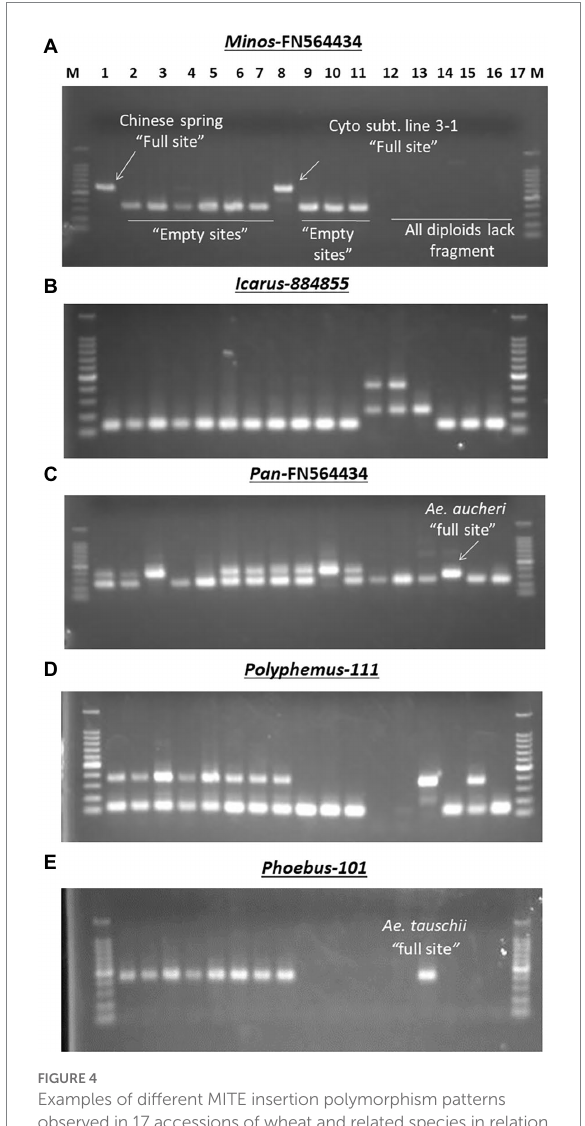
FIGURE 4 Examples of different MITE insertion polymorphism patterns observed in 17 accessions of wheat and related species in relation to ploidy and/or genome types. (A) Amplification patterns observed with Minos -FN564434: in this case, only the hexaploid cv. Chinese Spring (Lane 1) and its Cytoplasmic substitution line 3–1 (lane 8) had the Minos element, termed as “full site”; the rest of the hexaploid accessions and the tetraploids had only the “empty site,” while all the diploids (lanes 12–17) showed band absence. (B) Amplification patterns observed with Icarus- 884,855: all the hexaploid and tetraploid accessions (lanes 1–11) and the SS diploid types (lanes 15–17) lacked the Icarus element with only the “empty site” present; in addition to the Icarus element present in Ae. tauschii (DD, lane 14), the two T. urartu (AA, lanes 12 and 13) possessed an additional ~450 bp-long unique fragment. (C) Amplification patterns observed with Pan – FN564434; all the hexaploid and tetraploid accessions [lanes 1–11, except Norin 61 and MSD-Original #1 (lanes 4 and 5, respectively)] had the Pan element; while all the diploids (lanes 12–17) except Ae. aucheri diploid accession (KU-1-3, lane 15) showed band absence. The relatively lower fragment position of the Pan element in KU-1-3 seems to suggest some sequence deletion in this accession. (D) Amplification patterns observed with Polyphemus-111; all the hexaploid accessions (lanes 1–8), Ae. tauschii (lane 14) and an accession of Ae. speltoides (lane 16) had the Polyphemus element; the tetraploid accessions (lanes